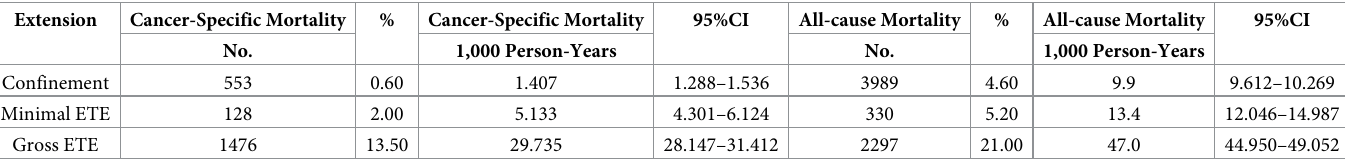
Table 3. Hazard ratios of different extent of tumor extension for the cancer specific deaths and all cause deaths of differentiated thyroid cancer. Extension Cancer-Specific